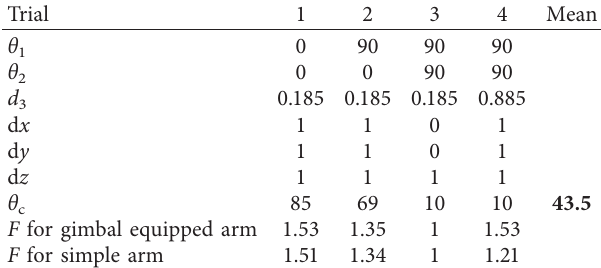
Table 4: GA optimization results for Stanford arm [11].